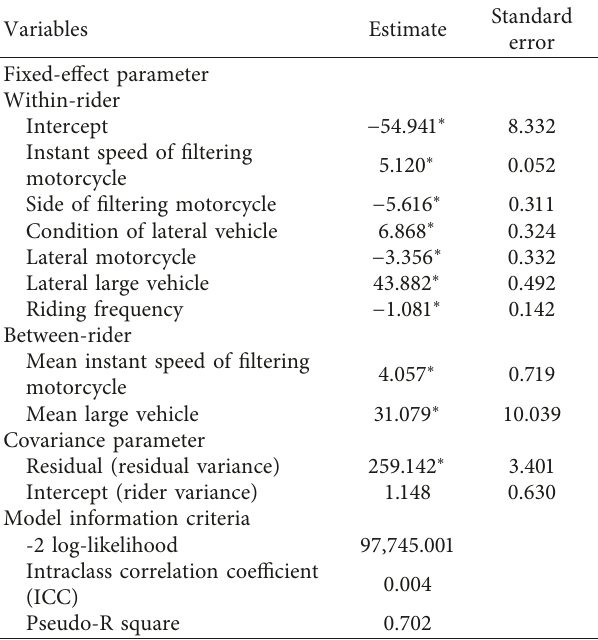
Table 8: Results of multilevel linear regression